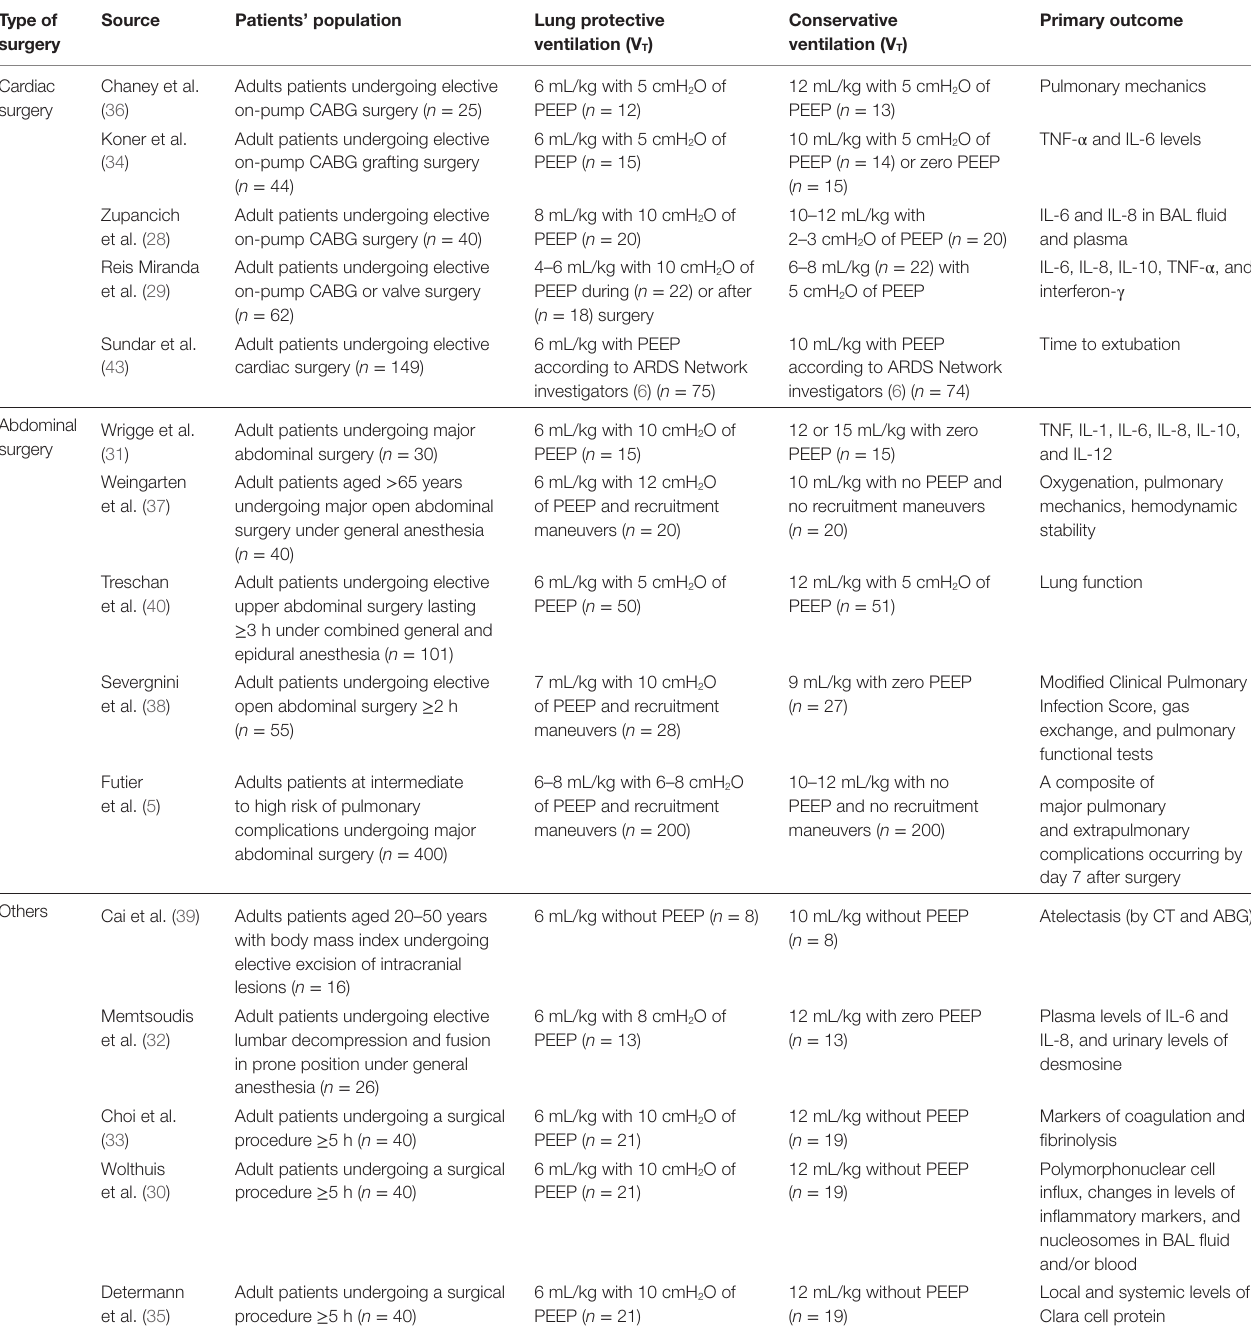
tABLe 1 | randomized controlled trials comparing lung protective strategies with low tidal volumes to conservative ventilation in operating